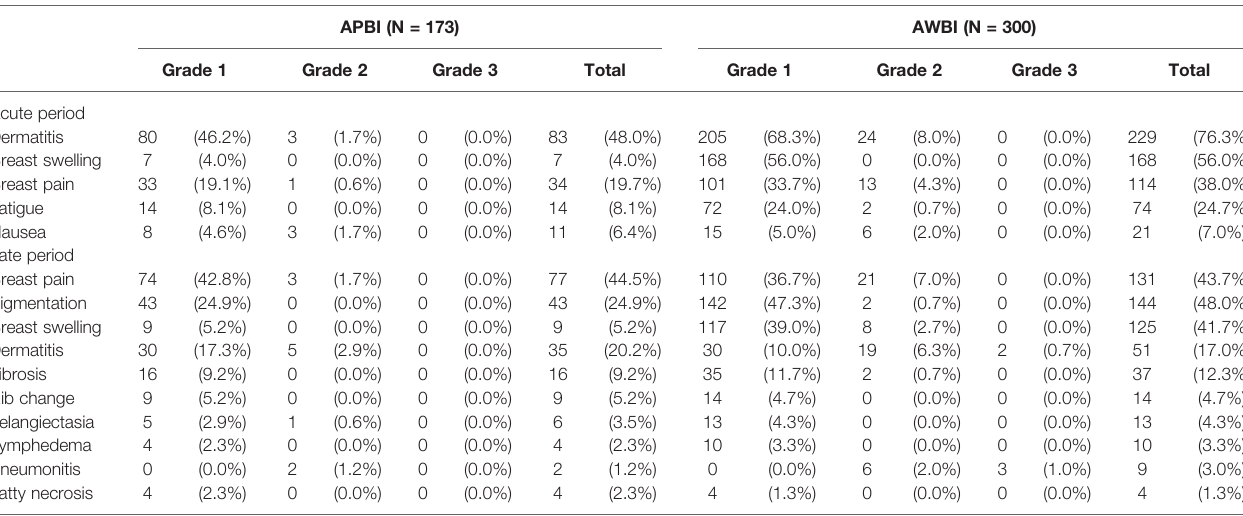
TABLE 4 | Acute and late radiation toxicities by treatment